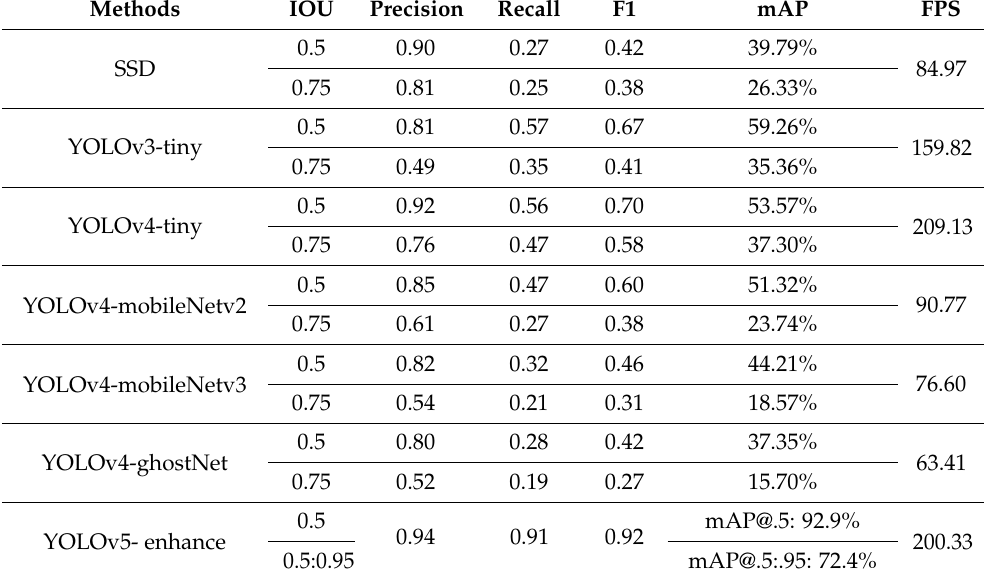
Table 6. Comparison of evaluation indexes after image filtering.